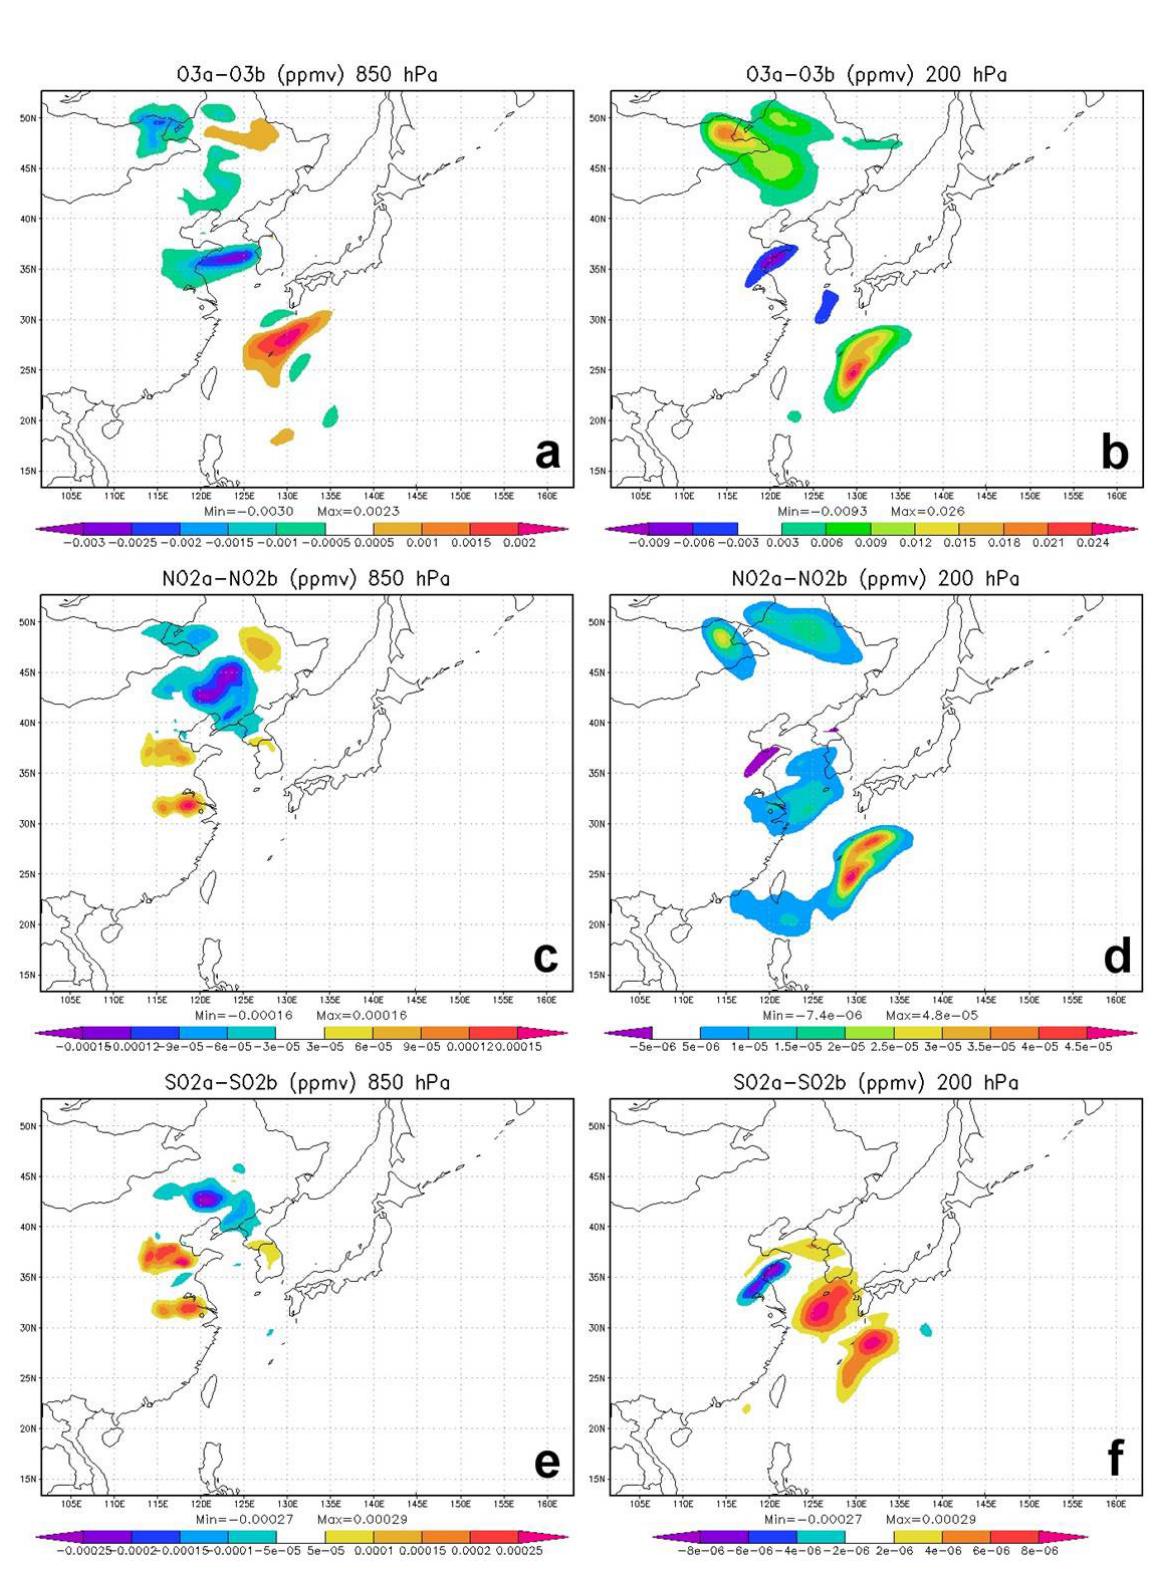
Figure 4. Same as in Fig. 2 except for analysis increment ( x a − x b ) of chemical variables in response to total column O 3 . Units are ppmv.